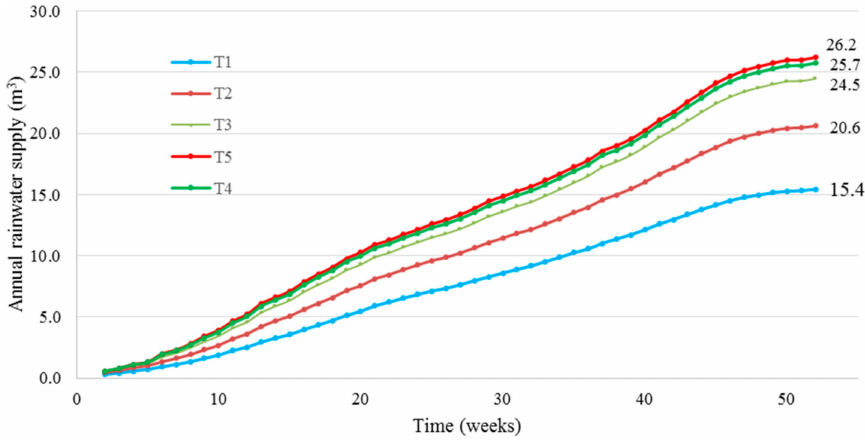
Figure 7. Cumulative rainwater supply for different RWH tank sizes.